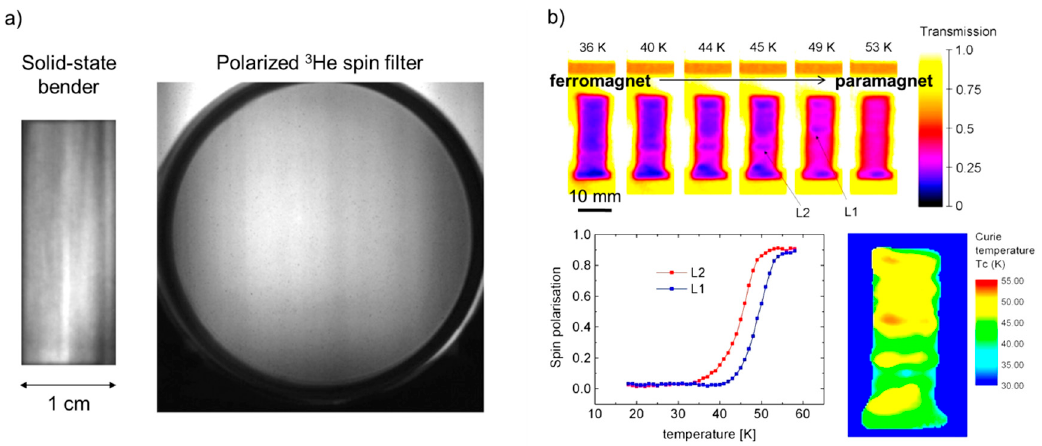
Figure 3. ( a ) Comparison between transmission images of a solid-state bender (left) and a polarized 3 He spin filter (right) [12]; ( b ) Mapping of phase transition process from the ferromagnetic to the paramagnetic state of a PdNi crystal (3.24% Ni) using a polarized 3 He spin filter setup [13].